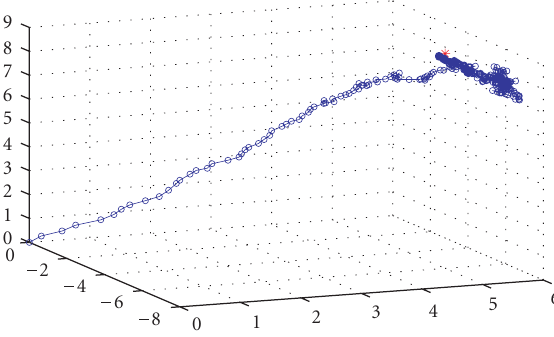
Figure 9: The path of searching for the favorable source